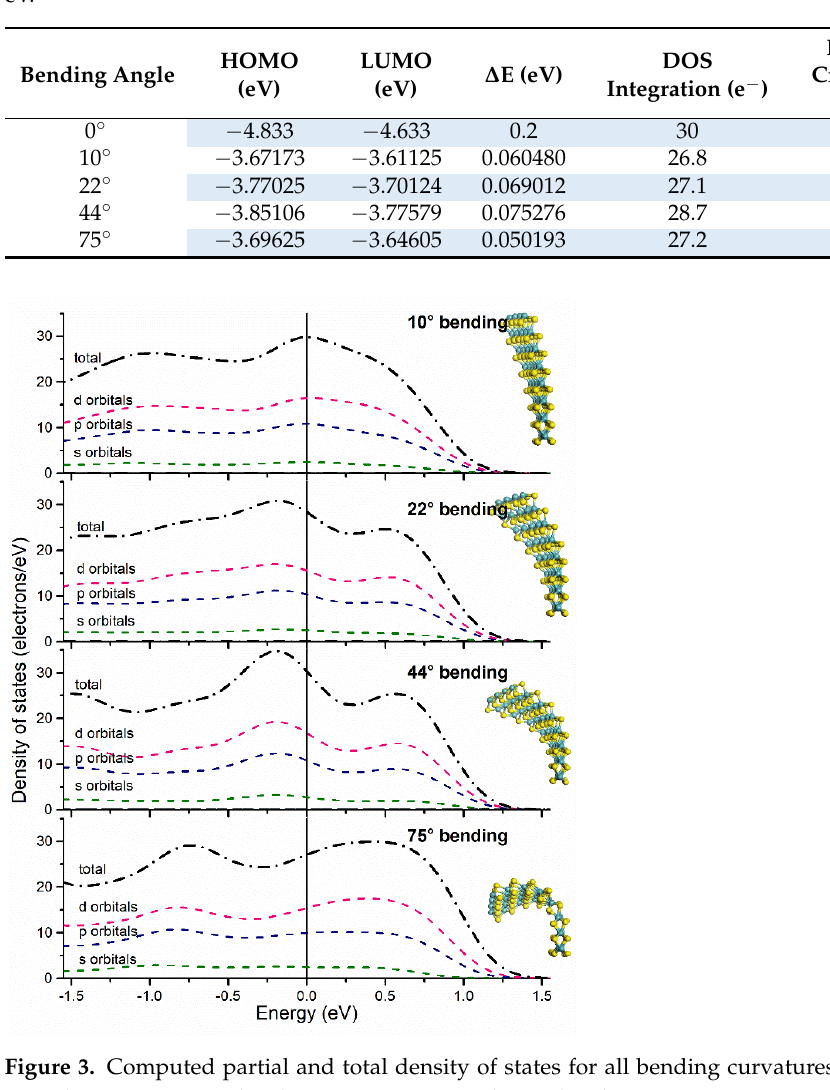
Table 2. The HOMO and LUMO computed values (units eV) for bending angles. ∆ E is the energy difference between HOMO and LUMO levels. DOS integration was computed from − 0.5 eV to 0.5 eV.